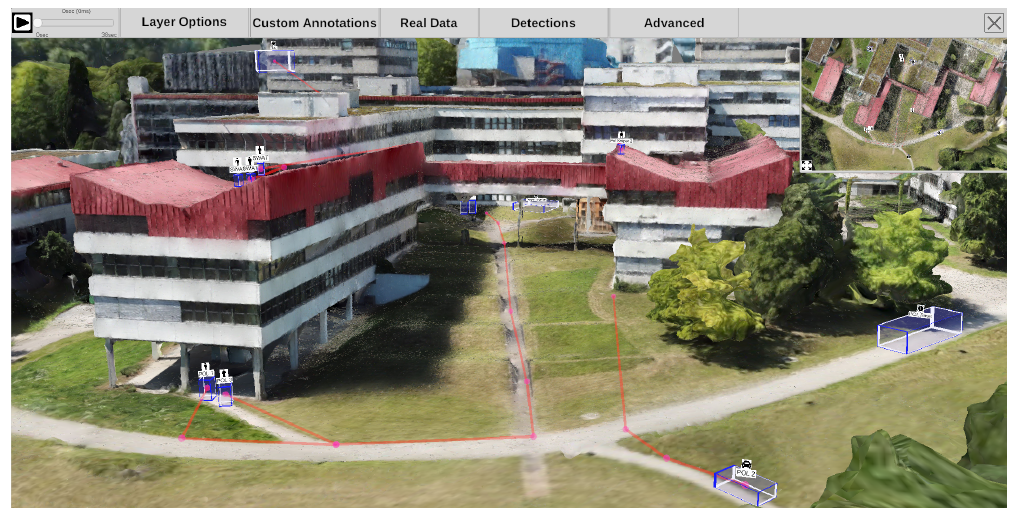
Figure 32. Exemplary reconstruction of the environment for strategy planning in police